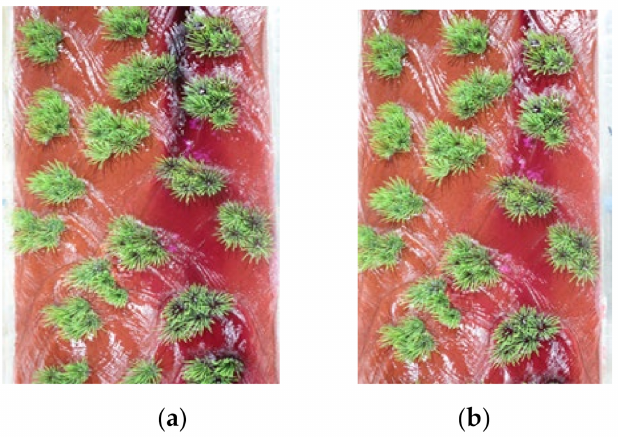
Figure 3. Flow velocity measurement using potassium permanganate ( a ) at the start of the experiment and ( b ) after 0.79